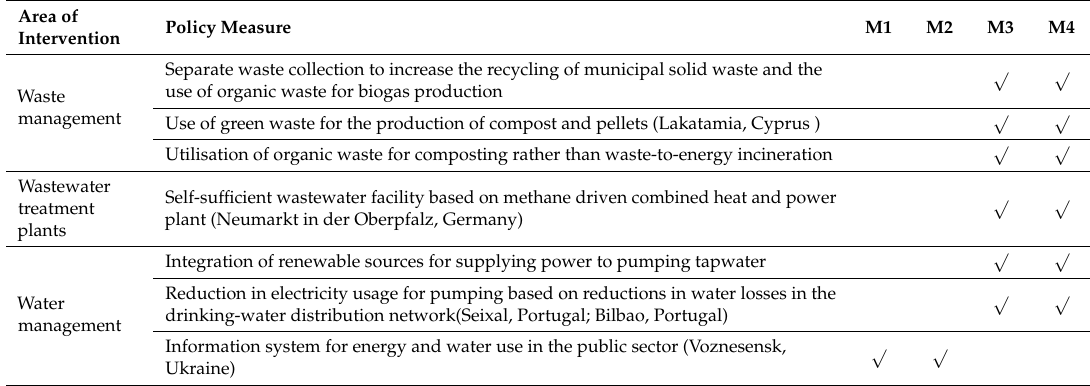
Table A3. Waste and water management (including wastewater treatment)